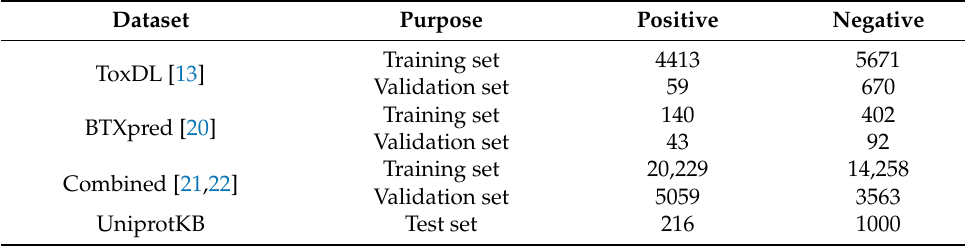
Table 1. Overview of the datasets